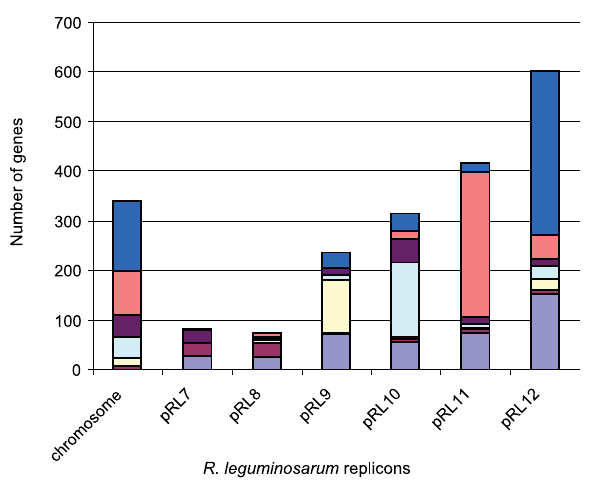
Figure 6. Composition of the R. leguminosarum and R.etli genomes according to N-CHR homologues. - The composition of the R. leguminosarum genome compared to the replicons of R. etli is shown. The replicon name is given at the base of the figure and color key to the right of the figure. Genes on the R. etli chromosome may be elsewhere on the R. leguminosarum genome (as shown in pale blue), genes from R. etli p42a (burgundy), p42b (cream), p42c (cyan), p42d (purple), p42e (salmon) and p42f are shown in royal